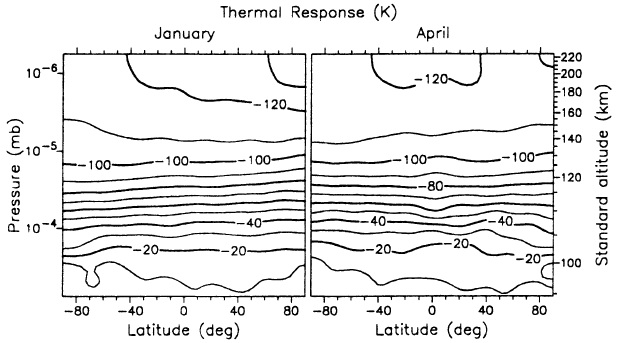
Fig. 9. Same as in Fig. 8. but above 95 km (contour interval